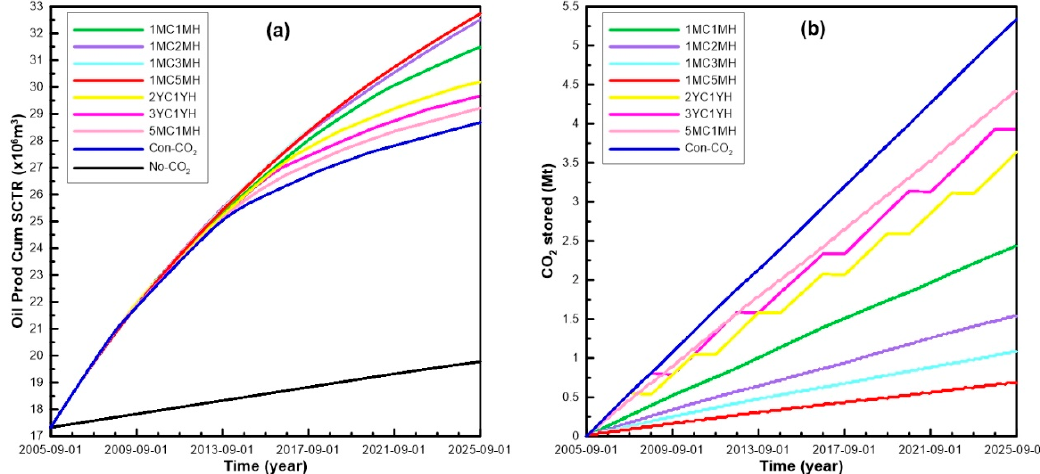
Figure 14. Simulated trend curves of cumulative oil production ( a ) and CO 2 stored ( b ) over time for the scenarios in simulation.